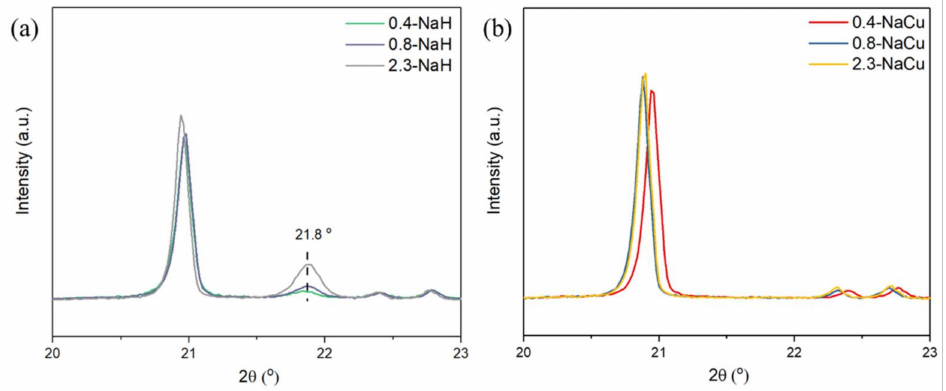
Figure 4. 20–23 ◦ XRD patterns of Na-poisoned ( a ) H/SSZ-13 supports and ( b ) Cu/SSZ-13 catalysts.